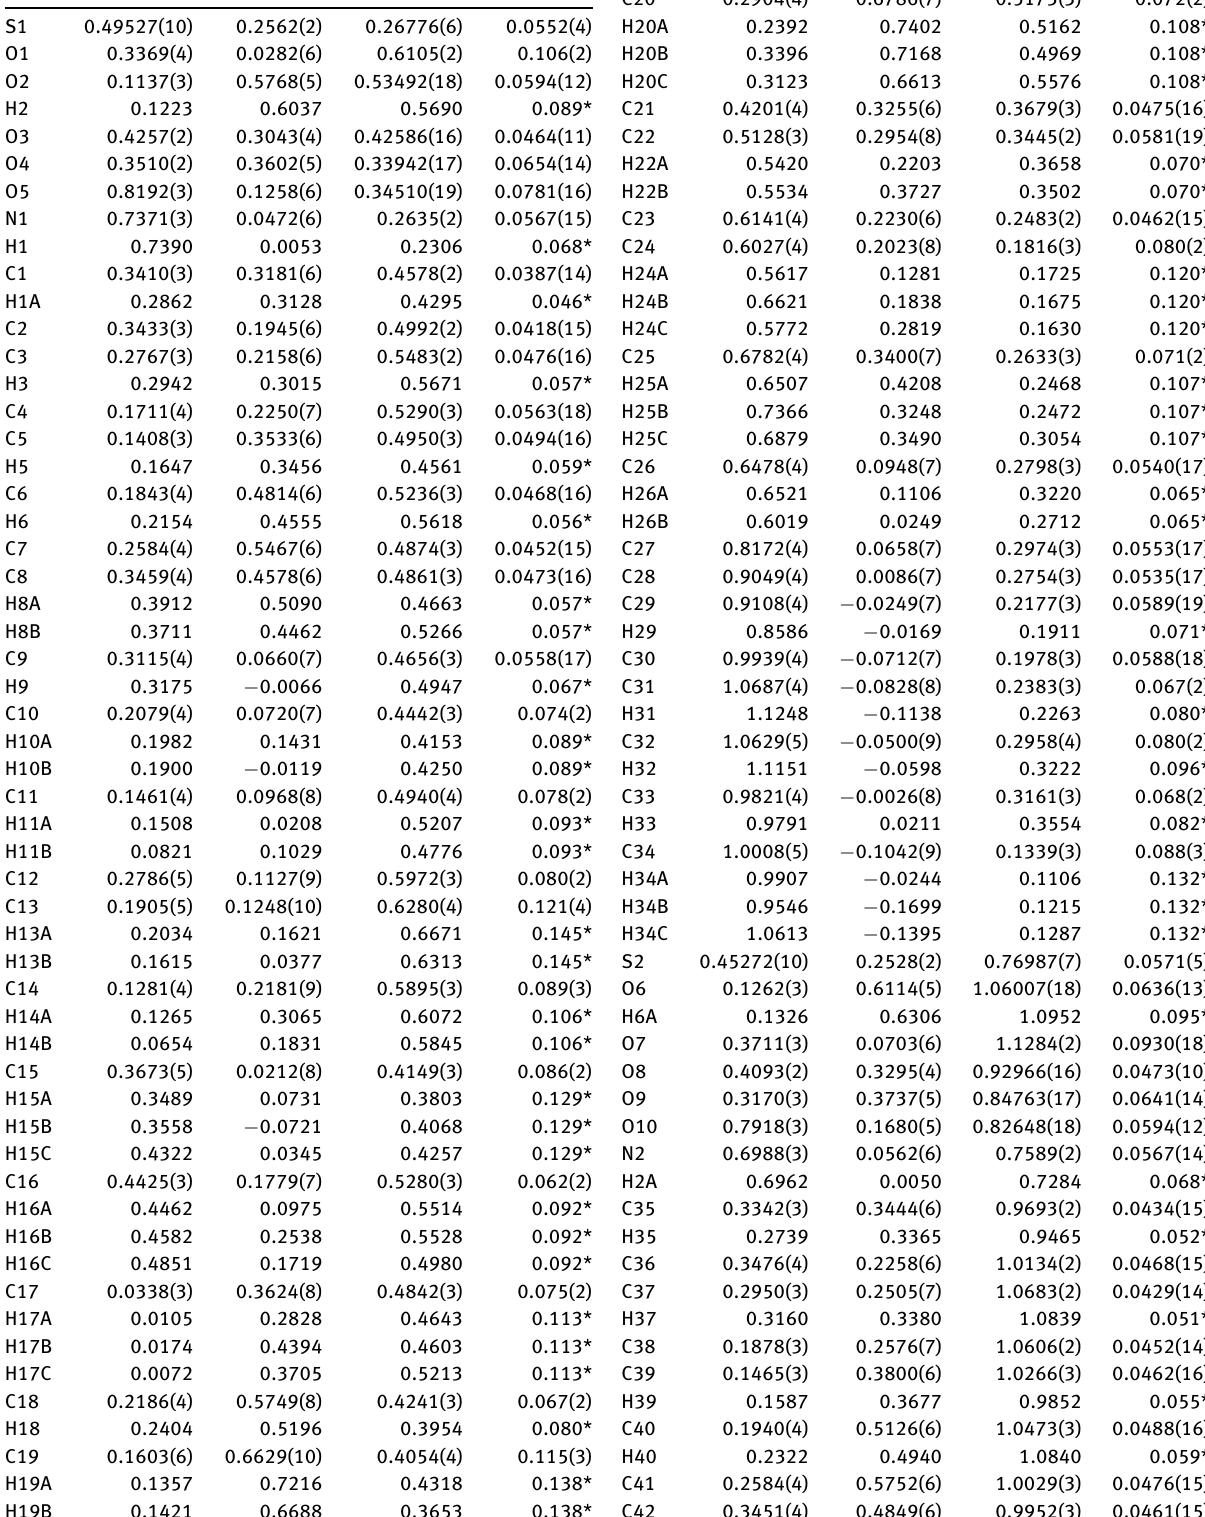
Table 2: Fractional atomic coordinates and isotropic or equivalent isotropic displacement parameters (Å 2